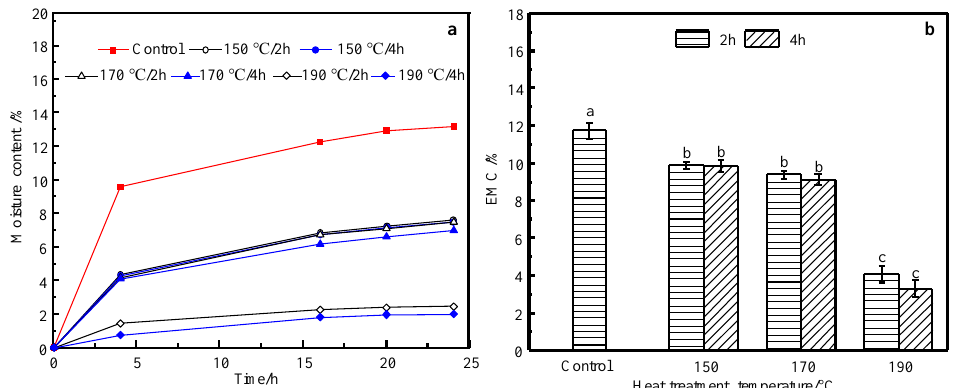
Figure 2. Short-term water vapor sorption process ( a ) and EMC after long-term water vapor sorption ( b ) of the control and HT wood. Bars with different letters indicate significant differences ( p < 0.05) according to Duncan’s multiple range tests.